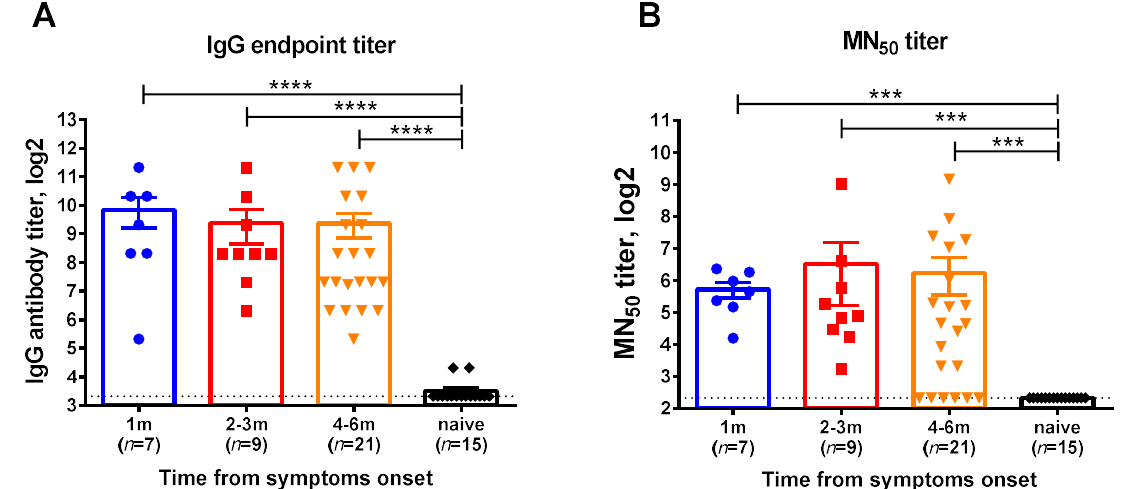
Figure 1. SARS-CoV-2 virus-specific antibody in serum samples of COVID-19 convalescents who participated in this study. ( A ) Serum IgG antibody titers determined in ELISA to RBD recombinant protein, ( B ) 50% virus-neutralizing titers determined by the MN 50 assay. The bars indicate the mean values and the error bars show standard error mean values. Data were analyzed by Kruskal − Wallis test with Dunn’s multiple comparisons test. *** p < 0.001; **** p < 0.0001.